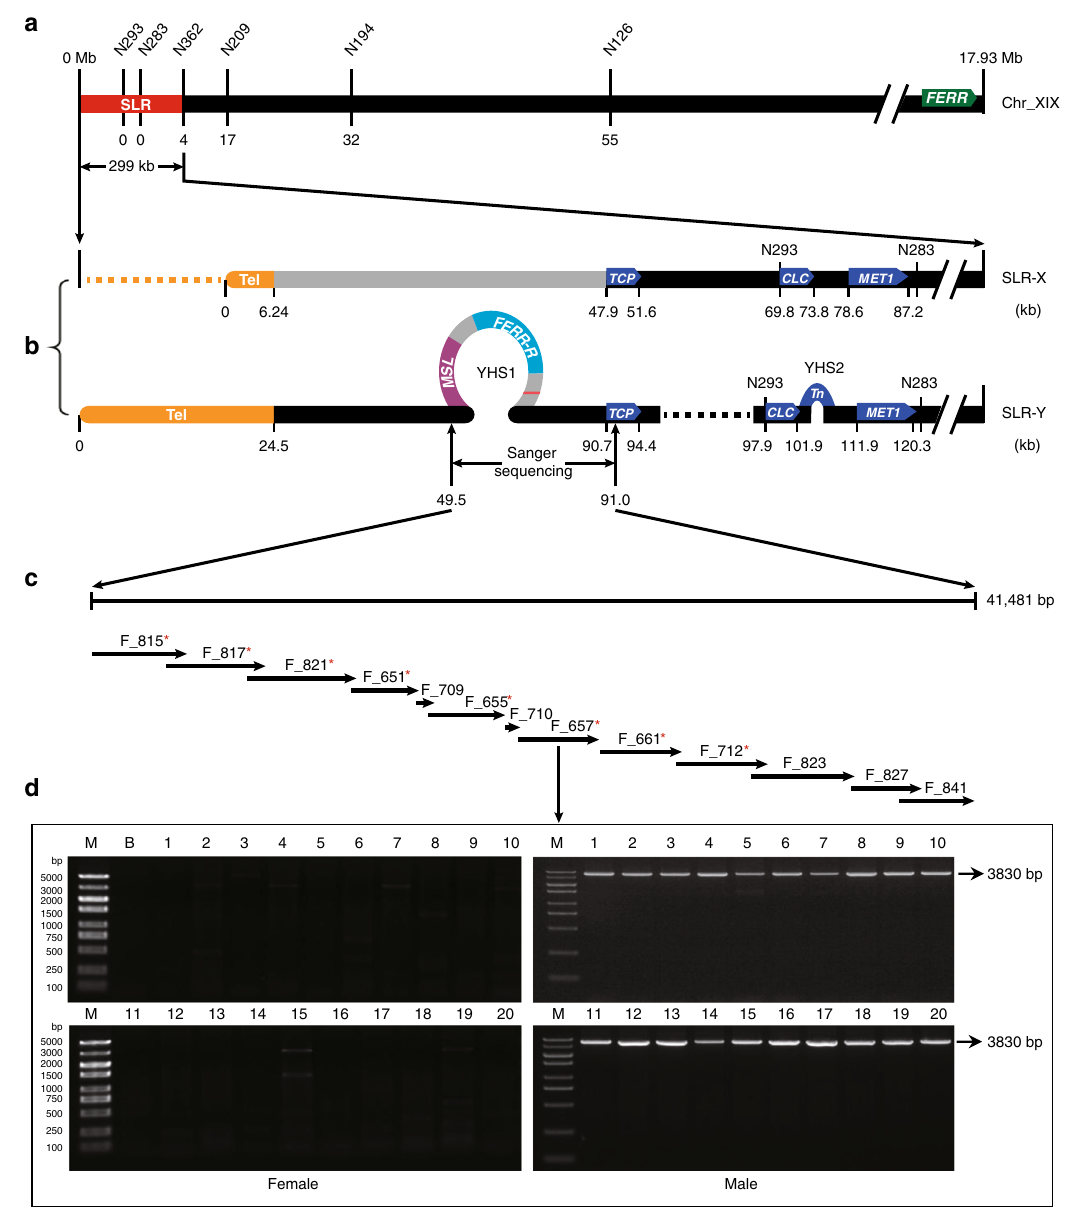
Fig. 1 Reconstructed haplotypes in the SLR of P. deltoides chromosome XIX. a Genetic map and physical positions of the SLR (red bar) and the telomere. SSR makers are shown on the top and the numbers of observed recombination events are shown under the chromosome diagram, with zero in both the genetic and physical maps at the telomere end of the chromosome. The FERR gene is located at the right end of chromosome XIX, the end most distant from the telomere of this telocentric chromosome. b SLR-X and SLR-Y haplotypes reconstructed from genome sequences of our sequenced male (see main text). The yellow bars at the left indicate the X and Y telomeres, and physical distances (kb) from the telomere end are shown under each bar. The dashed lines represent deleted sequences, whereas the loops on SLR-Y represent the two Y-speci fi c hemizygous sequence (YHS) described in the text. The gray portion on SLR-X indicates a region described in the text, where divergence between SLR-X and SLR-Y is higher than elsewhere in the SLR. c The Y-speci fi c region rebuilt from 13 PCR ampli fi ed fragments (fragment names are shown above the arrows). Red asterisks indicate the fragments are further ampli fi ed with natural stands of P. deltoides . d Agarose gel electrophoresis pro fi le for fragment F_657 in females and males. Similar results were obtained in two independent experiments. M molecular marker, B blank control. Source data underlying d are provided as a Source Data fi